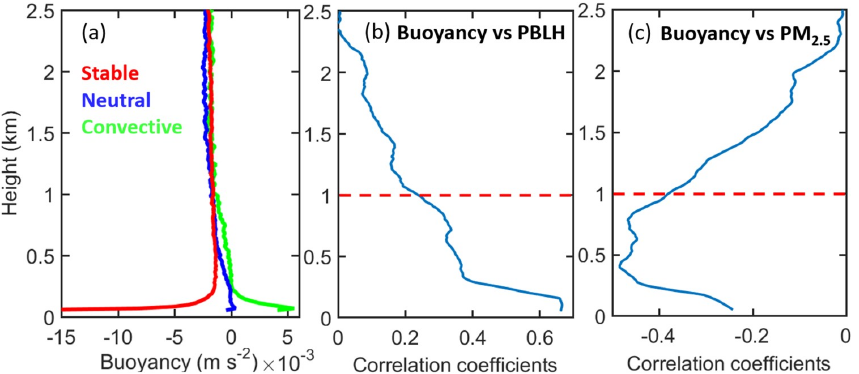
Figure 2. (a) Averaged vertical profiles of buoyancy forcing in stable, neutral, and convective PBLs. (b) Height-dependent correlation coefficients between buoyancy and PBLH. (c) Height-dependent correlation coefficients between buoyancy and surface PM 2 . 5 . Note that the PBLH and surface PM 2 . 5 are fixed for the entire column, and the buoyancy is height dependent. The buoyancy in the lower atmosphere ( < 1km) has the most important impact on the PBLH and surface PM 2 . 5 . The buoyancy and PBLH are calculated from RS measurements made at 14:00LT and 20:00LT from 2011 to 2018.